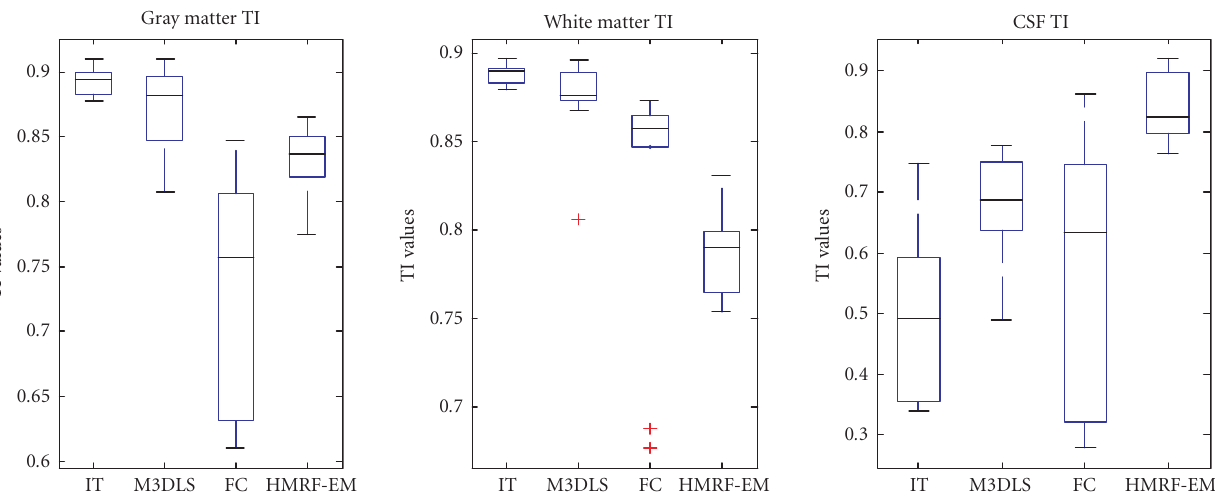
Figure 11: Box plot of TI values, over the four segmentation methods (IT, M3DLS, FC, HMRF-EM) for the 10 clinical cases. for GM, WM and